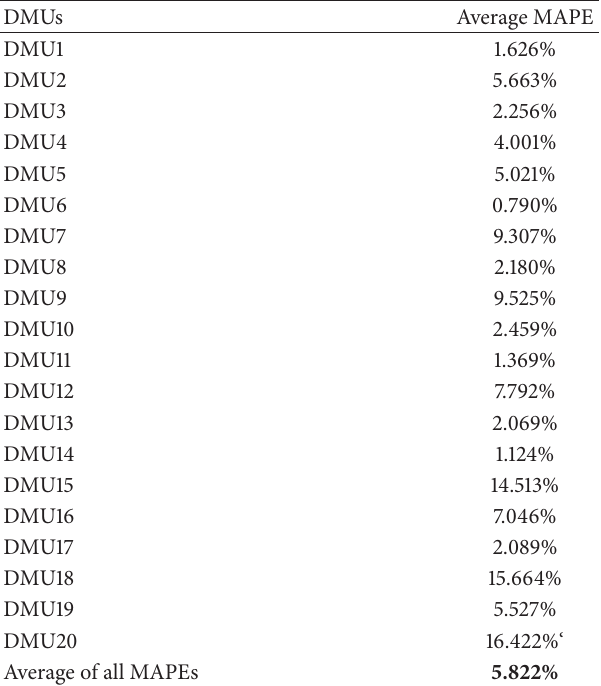
Table 5: Average MAPE of DMUs.